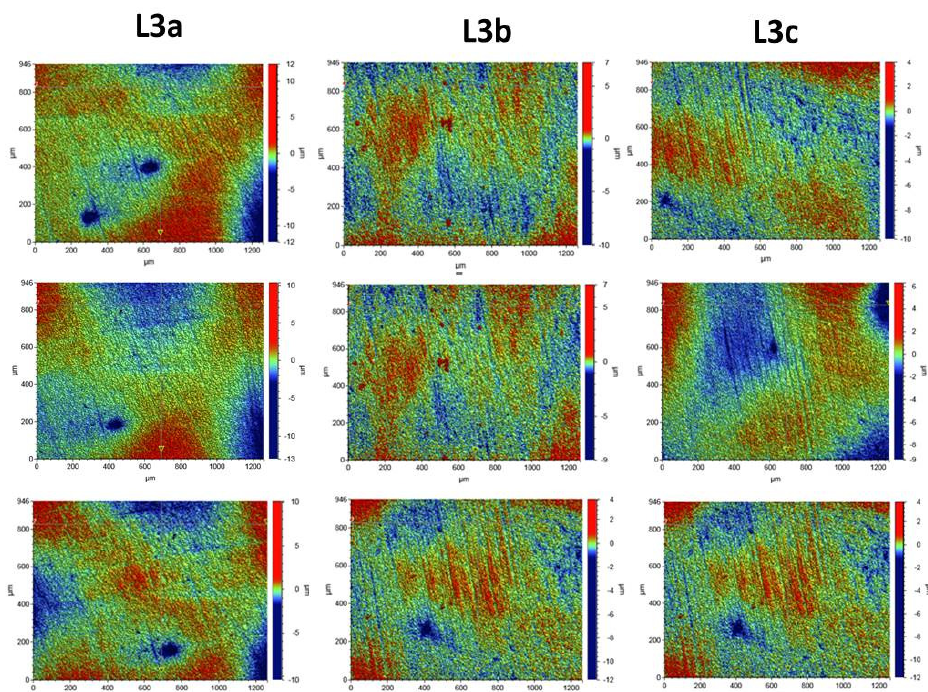
Figure 6. Surface microgeometry maps determined for the K2 composite for 3 variants of laser L3. L3a (periimplantitis variant, sweep technique, 60 s), L3b (periimplantitis variant, sweep technique, 2 × 30 s with 60 s cooling break) and L3c (periimplantitis variant, scoring technique, 60 s).